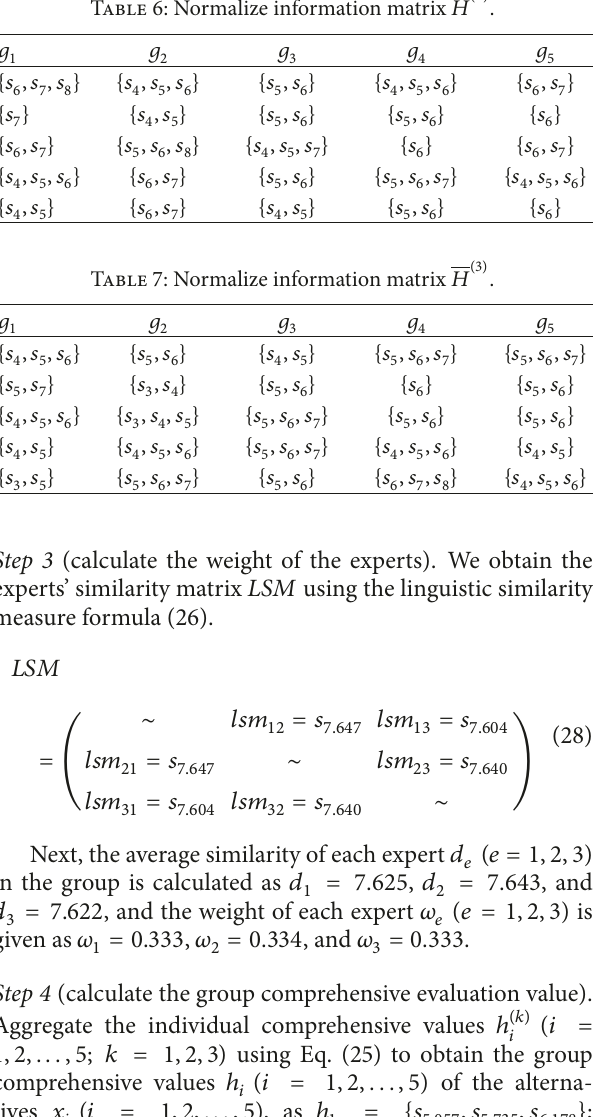
Table 6: Normalize information matrix 𝐻